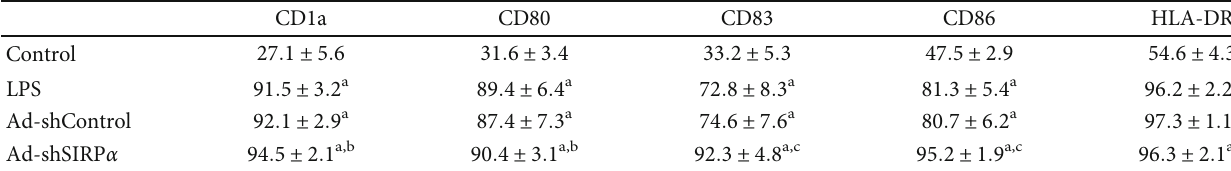
Figure 1: The analysis of SIRP α inhibition. The SIRP α inhibition e ffi cacy mediated by recombinant adenovirus was analyzed by Western blot, and the results were quanti fi ed by ImageJ. Lane 1: Ad-shControl (MOI 10.0); lane 2: Ad-shSIRP α (MOI 10.0). Table 1: Percentage of DCs expressing CD1a, CD80, CD83, CD86, and HLA-DR.